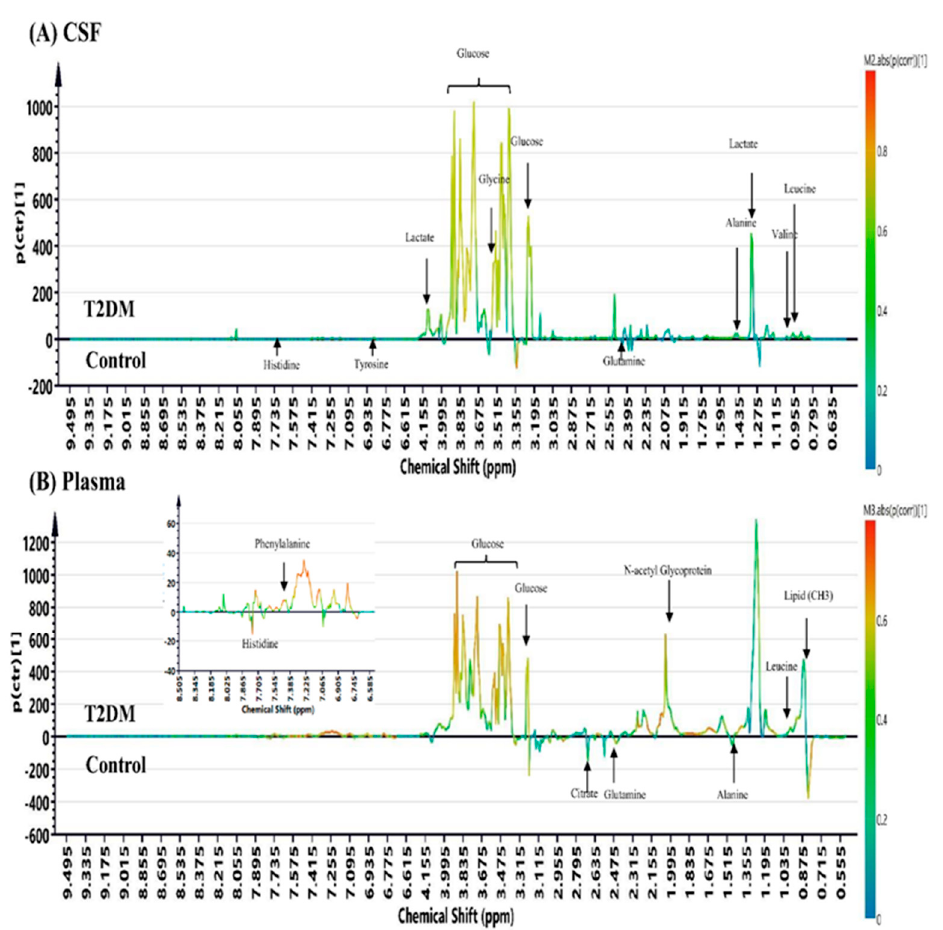
Figure 3. The OPLS-DA coefficient loading plots of NMR signals in ( A ) CSF and ( B ) plasma (excluded EDTA signals) samples obtained from T2DM patients versus control subjects.